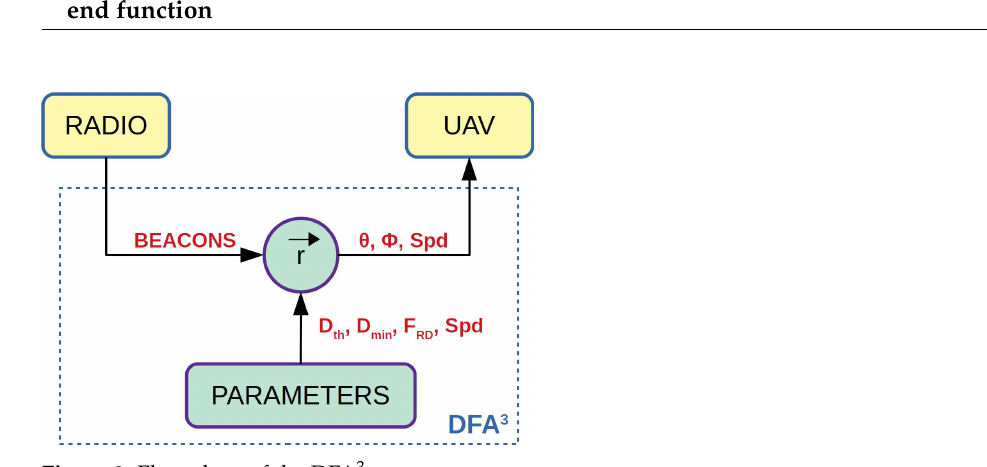
Figure 2. Flow chart of the DFA 3 .